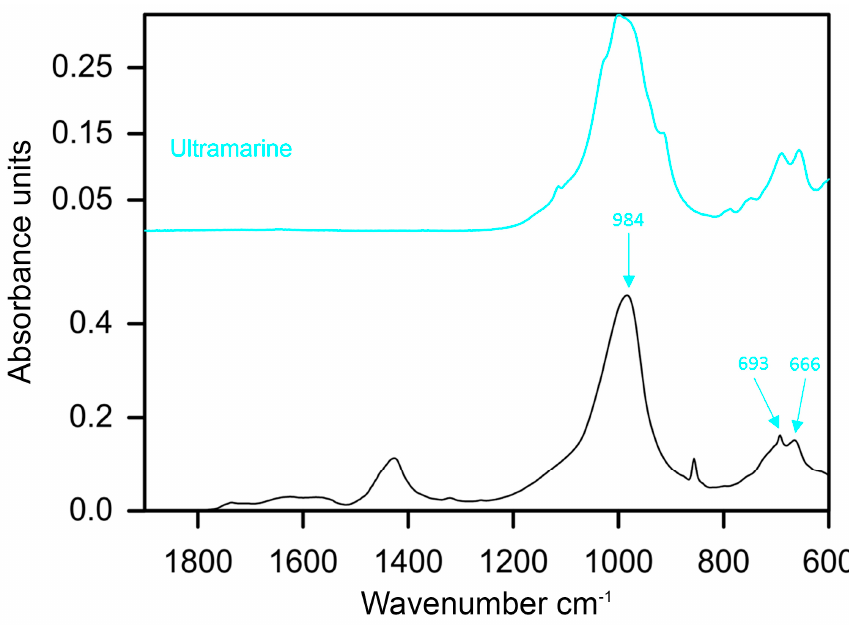
Figure 7. ATR–FTIR spectra derived from the blue paint of sample 6, collected from Countryside in China , 1933, with labelled marker peaks of ultramarine and reference spectra of the same pigment. The blue hue was often modified by combining prevalent ultramarine with other blue, green and yellow pigments. For instance, the addition of Prussian blue (PB27) to ultramarine is assumed in paint sample 4 from Waterfall (1936). The pigment was tentatively identified with PLM (observation of dark blue isotropic particles that appear dark green with a Chelsea filter and have a low refractive index), by SEM-EDS detection of iron and an IR absorption peak at 2093 cm − 1 . The results of the analyses conform with IRFC imaging, as the violet colour of the sampling area is determined by a blue representation of Prussian blue and a purple representation of